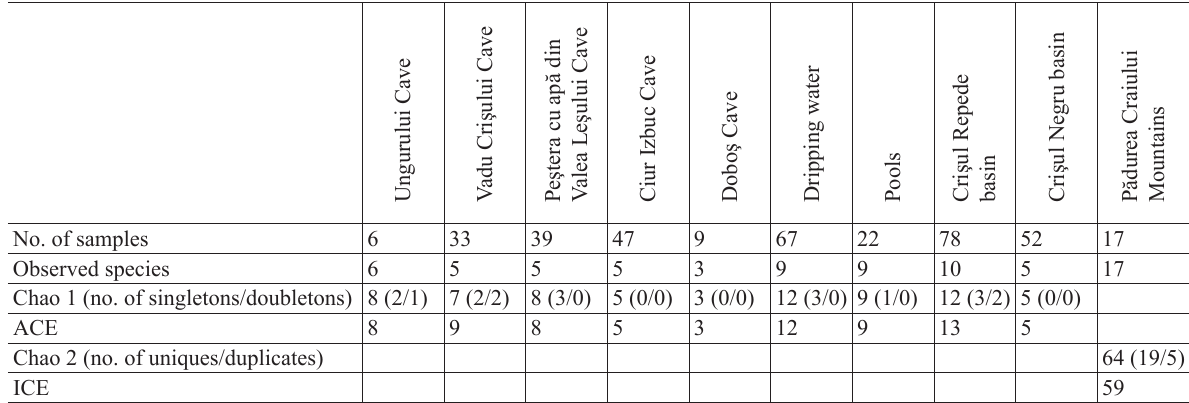
Tabel 2 - Species richness estimators computed at different spatial